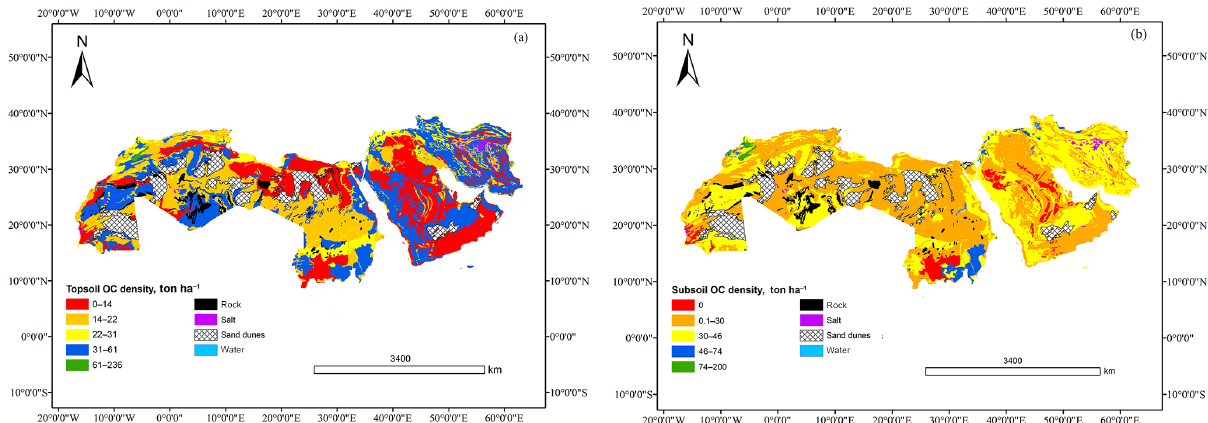
Figure 3. Spatial distribution of SOC density (tonha − 1 ) in topsoils (a) and subsoils (b) of the NENA region.